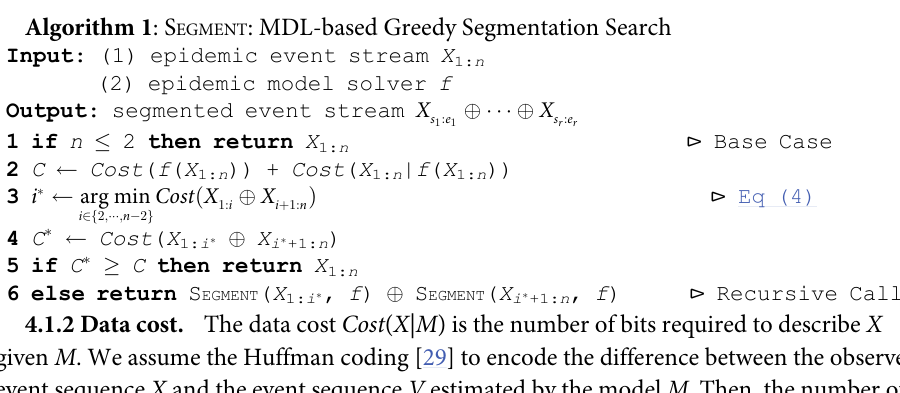
Algorithm 1 : S EGMENT : MDL-based Greedy Segmentation